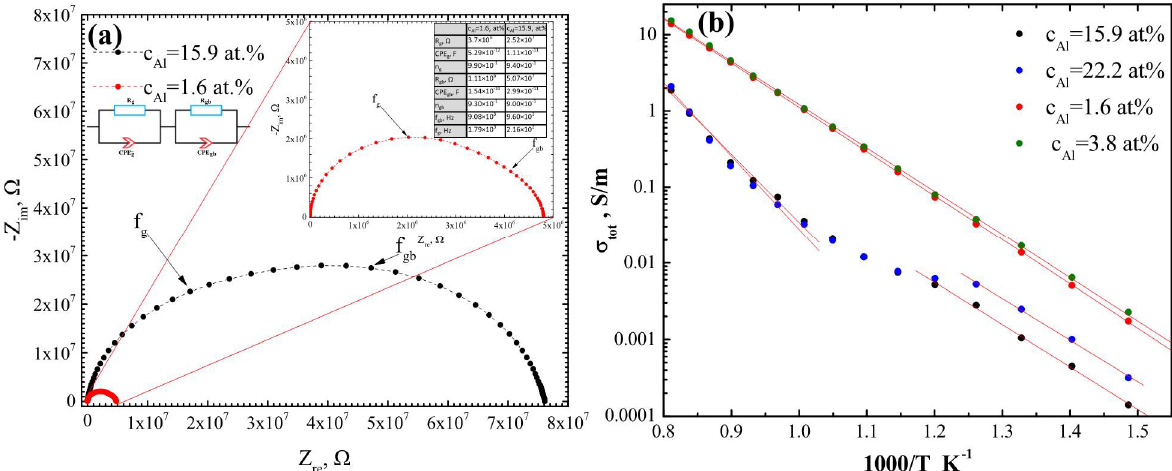
Figure 4. ( a ) Nyquist plots of ScAlSZ thin films with 15.9 and 1.6 at.% of Al at 560 ℃ and ( b ) Arrhenius’ plots of ScAlSZ thin films with different Al concentrations.